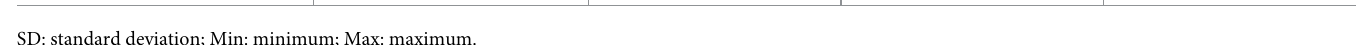
The accuracy of the marginal fit is considered to be one of the most important criteria for eval- uating the quality of dental prostheses. According to previous studies, the average discrepancy of marginal fit has been reported to range from 177 μ m to 400 μ m for interim crowns [45, 46], and from 100 μ m to 200 μ m for definitive prostheses [47–50].The marginal gap of the interim crown fabricated from a CBCT-based digital model in this study was measured to be 132.96 μ m. Given that internal and marginal fits are generally less crucial for an interim crown than for a definitive crown, the results of our experiment are within the clinically acceptable range. The marginal gaps between the mesiodistal and buccolingual surfaces of the CBCT-digita- lized, 3D-printed interim crowns did not show statistical significance in any measurement area, whereas there were significant differences between the measured discrepancies depend- ing on measurement points (e.g., MA, AA, AOA, and OA). Kim et al. [14] reported that a study assessing linear length values of the CBCT-scanned digital models with the values acquired from a coordinate measuring machine resulted in greater errors in the Z-axis (height) direction than in the X- and Y-axis directions. Moreover, in a previous study that evaluated the internal gap of 3D-printed interim crowns fabricated by the silicone replica method, the discrepancy of the occlusal area was found to be larger than those of other areas. In this experi- ment, the occlusal area had the highest internal gap, with an average of 255.88 μ m (median: 244.94 μ m), which was a higher error value than the average of the marginal gap (mean: 132.96 μ m, median: 86.00 μ m). It can be assumed that errors may accumulate during the pro- cesses of conventional impression taking, CBCT scanning and 3D printing. Despite the large internal gaps of the 3D-printed crowns, the measured errors are still within the clinically per- mitted range of interim crowns (177–400 μ m) [45, 46].